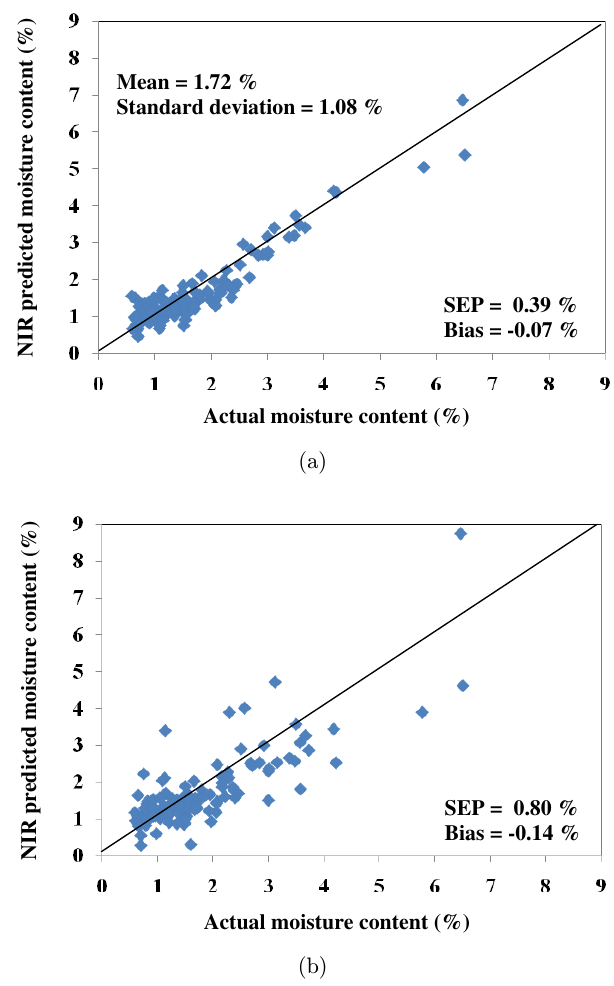
Fig. 5. Scatter plots of single sheet system (a) and a pile of sheet system (b) in the validation set.